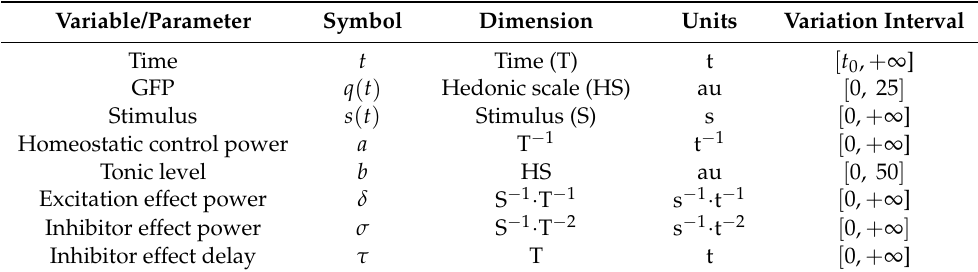
Table 1. Dimensions, units and the variation intervals of the variables and parameters involved in the stimulus–response model of Equation